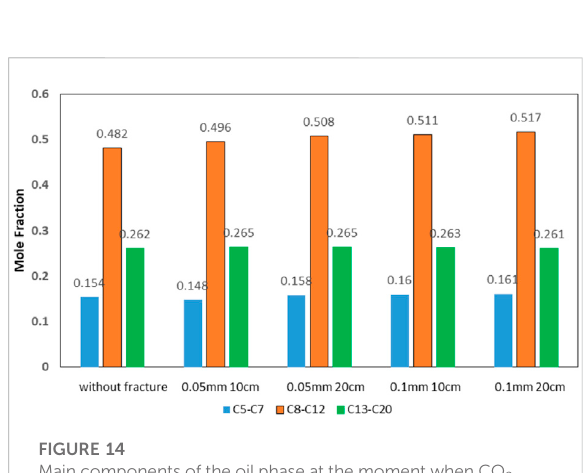
FIGURE 12 Pressure in different experiments.